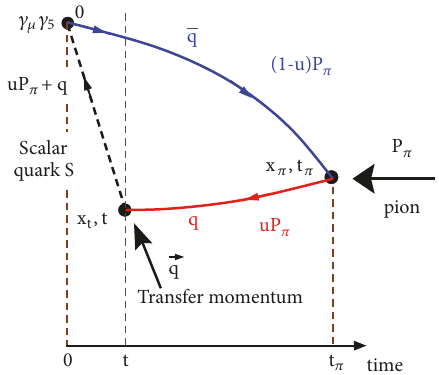
Figure 1: Schematic representation of the three-point function that needs to be computed to extract the pion light-cone wave function [64–66]. Source: arXiv version of [66], reprinted with permission by the